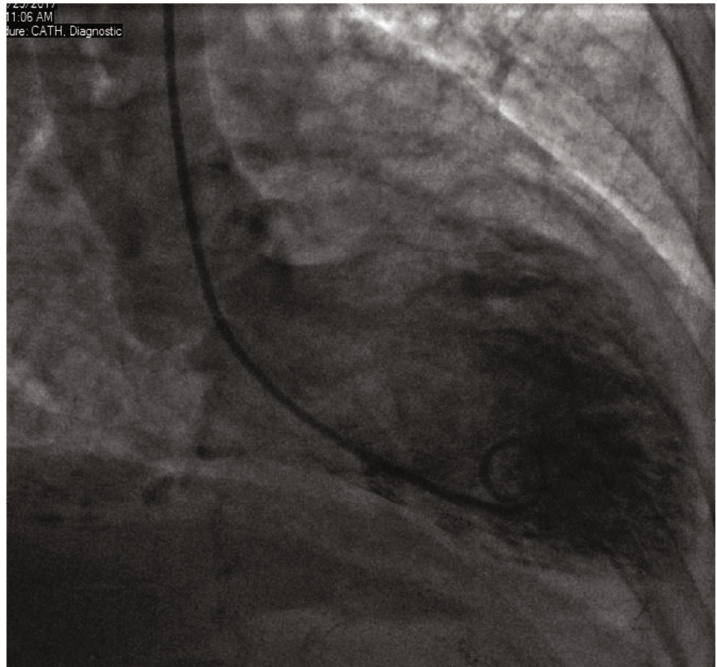
Figure 5: Left ventriculogram in diastole.